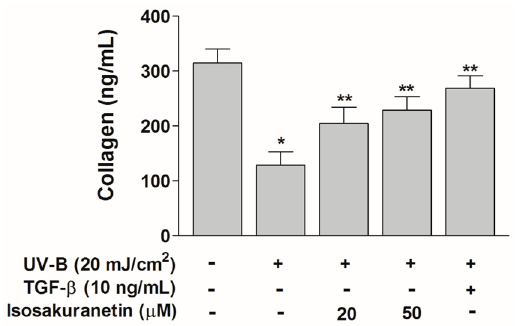
Figure 6. Effect of isosakuranetin on the level of type-1 procollagen in UV-B-irradiated NHDF cells. After pretreatment of fibroblast cells with different concentrations of isosakuranetin for 24 h, cells were irradiated with UV-B (20 mJ/cm 2 ), and then cells were further incubated for 24 h. Total collagen levels were measured in the culture media of control cells or UV-B-treated cells by SirCol assay. Data shown are mean values ± S.D. * p < 0.05 vs. non-UV-B-irradiated cells, ** p < 0.05 vs. UV-B-irradiated cells.